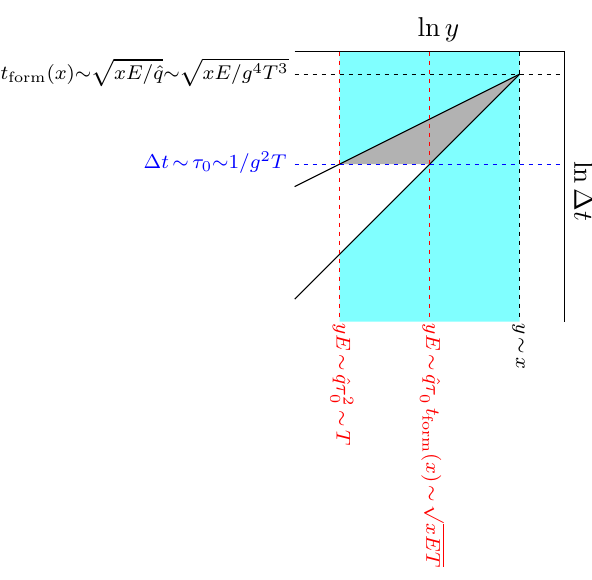
Figure 2 . Parametric scales associated with various features of figure 1(b). The light blue region, combined with the gray region, shows where the ˆ q approximation is useful in our (theoretically idealized) application. In the lower light-blue region, ˆ q -approximation propagators over the short time of the y emission are approximately vacuum propagators. We have only shown y < x above because, in our discussion here, y represents the softest